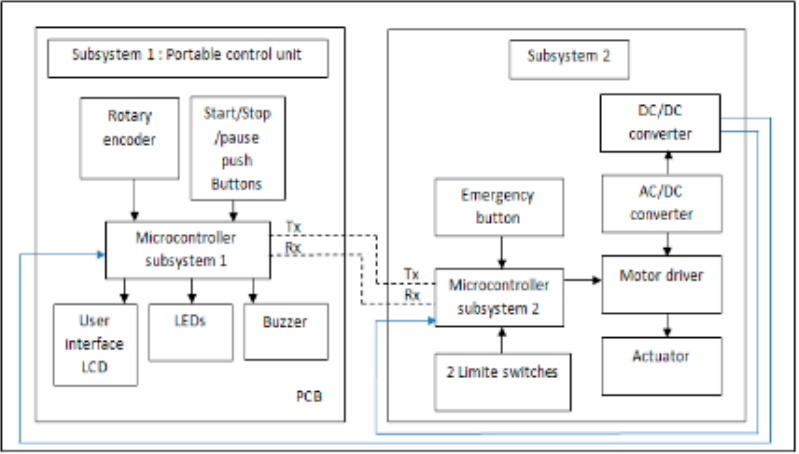
Figure 7. Electrical of design of the FWRMS Continuous Passive Motion (CPM)